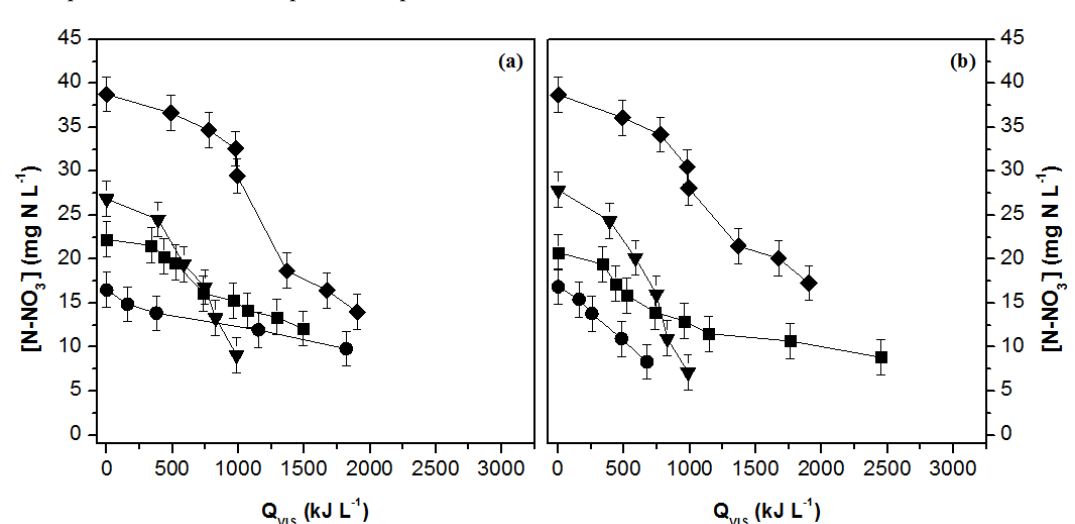
Figure 5. Variation of nitrogen concentration (N-NO 3 − ) as a function of the accumulated visible energy ( Q VIS ) in PBR 1 ( a ) and PBR 2 ( b ) for all assays: I— (cid:4) ; II— • ; III— (cid:72) ; IV— (cid:7) . Error bars correspond to the standard deviation of the mean determined for duplicates from two independent experiments.